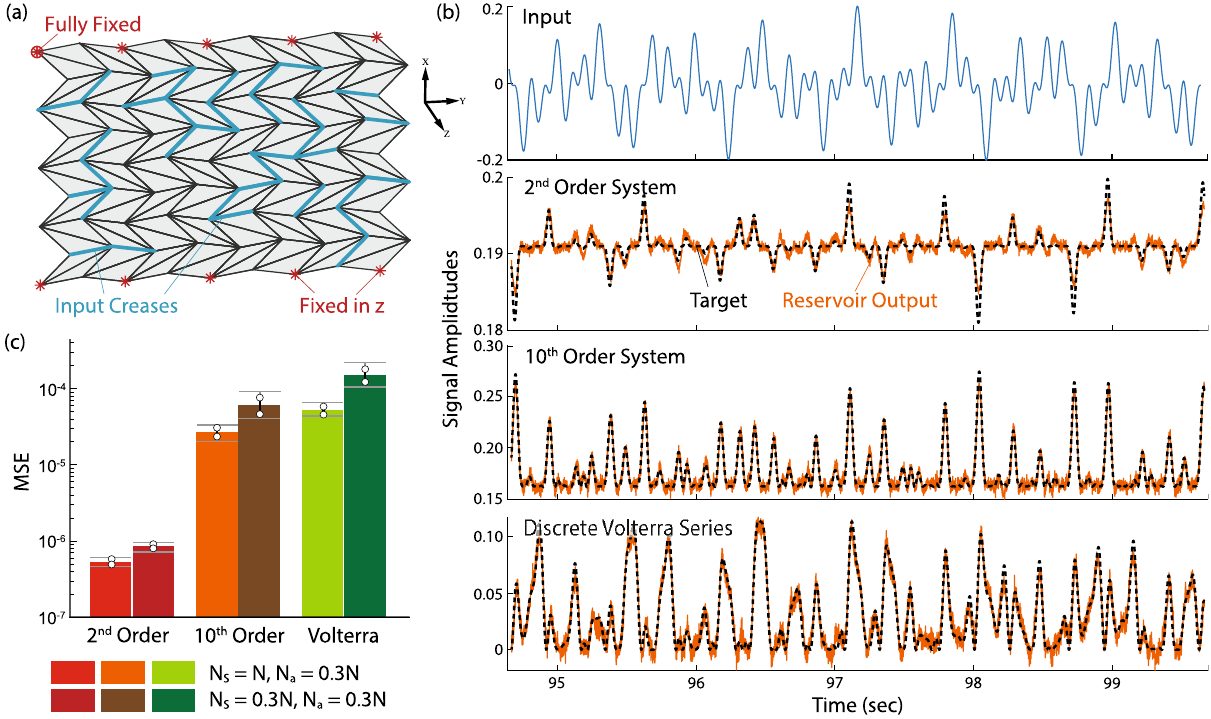
Figure 3. Emulation tasks with the origami reservoir. ( a ) The Miura-ori reservoir used for this task with input creases highlighted. Appropriate boundary conditions are also necessary. ( b ) Examples of trajectories generated in the emulation task including (from top to bottom) input signal u ( t ), 2nd order, 10th order system, and Volterra series. Dashed curves are the targeted trajectories, and solid curves are the result of the reservoir. ( c ) Error analysis of the emulation tasks. Circles are the standard deviation of MSE, and horizontal bars are the corresponding extreme